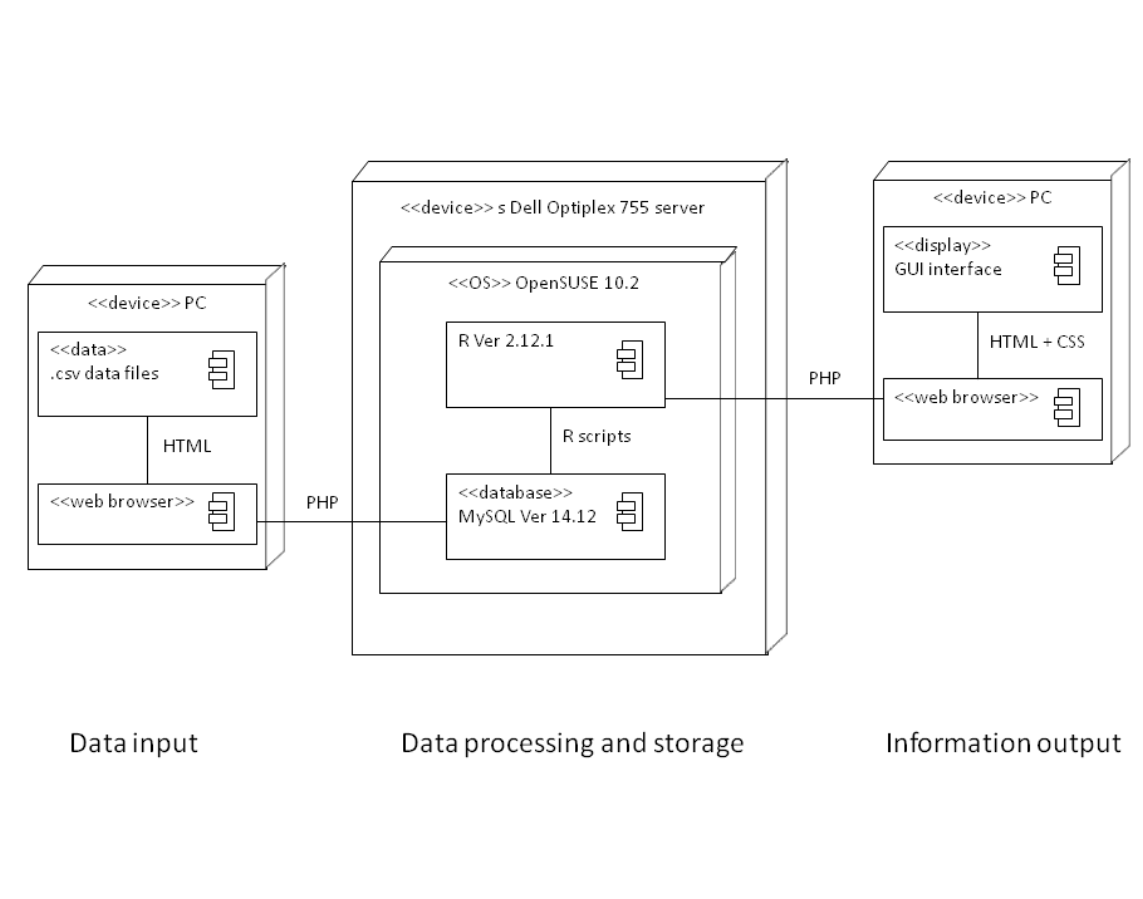
Figure 1. Deployment diagram of the surveillance dashboard